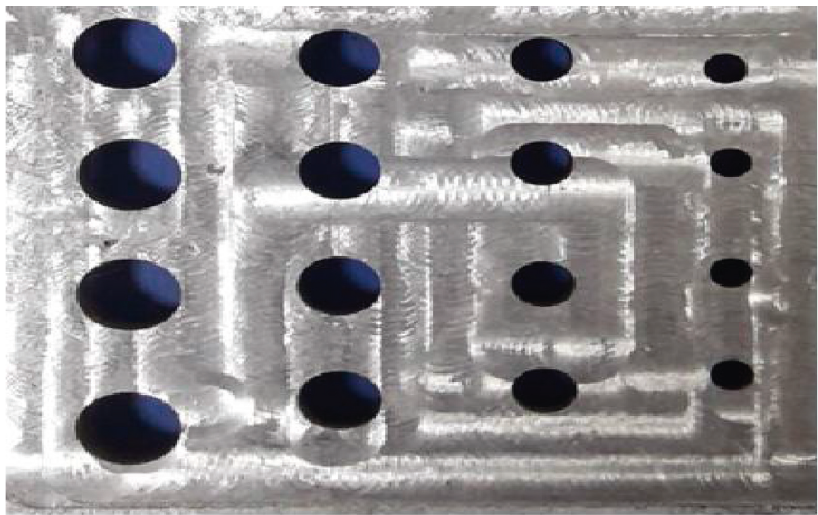
Figure 3: Holes made on T6 aluminum alloy.